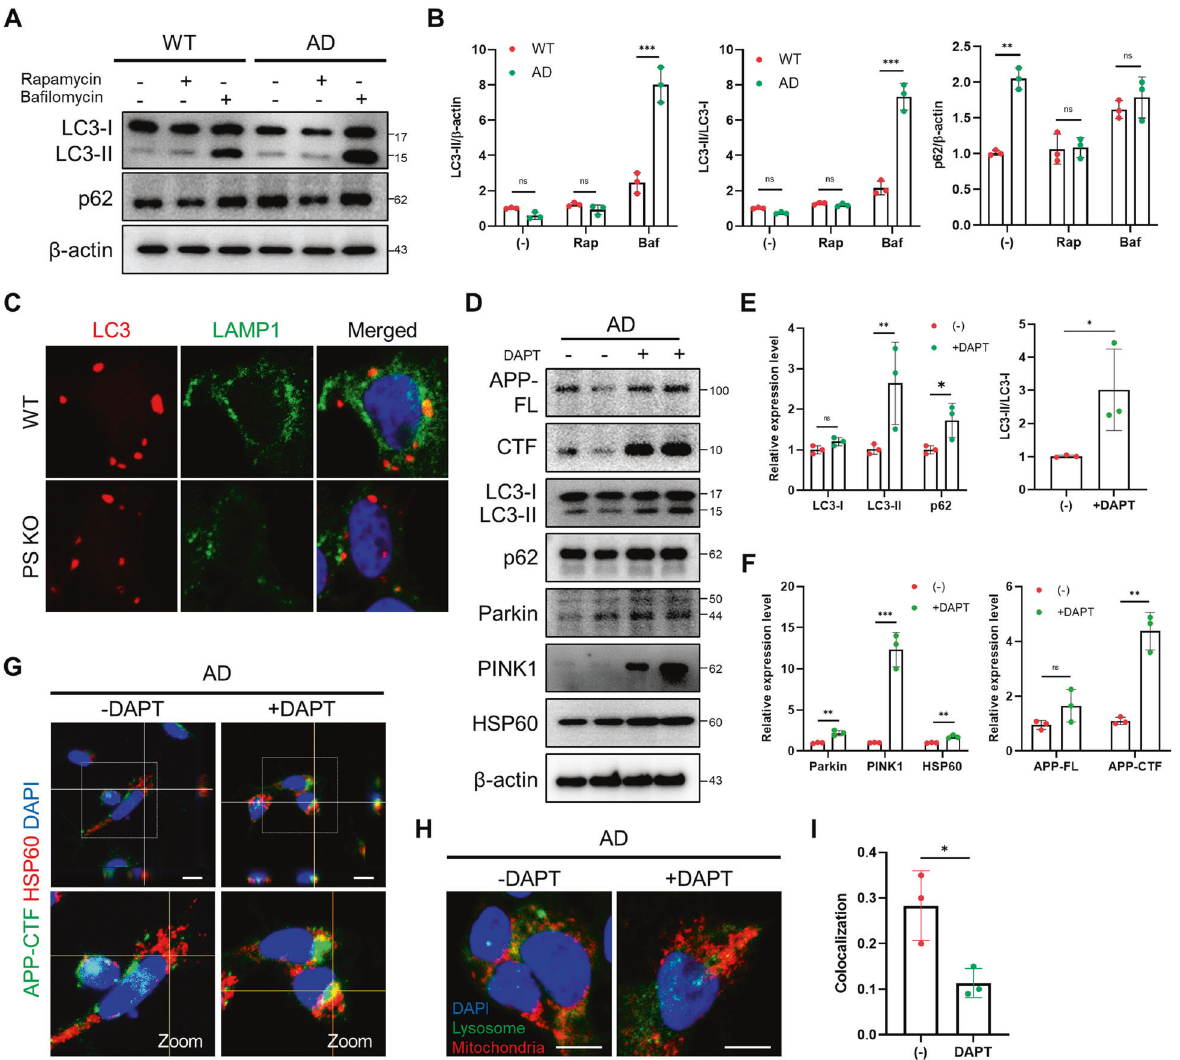
in WT- and AD-iNSCs with respect to control iNSCs under vehicle-treated conditions. C Representative images showing LC3 and LAMP1 in WT- and AD-iNSCs under basal conditions. D Representative western blotting showing APP, APP-CTFs, LC3, p62, Parkin, PINK1, HSP60, and β -actin expression in AD-iNSCs treated or not with DAPT for 24 h. E Quanti fi cation of autophagy-related markers, including LC3 and p62, in the presence of DAPT relative to vehicle treatment. F Quanti fi cation of APP-CTFs and mitophagy-related markers, including Parkin, PINK1, and HSP60, in the presence of 10 µM DAPT relative to vehicle treatment. G Representative z-stack images showing APP-CTF in green and HSP60 as a mitochondrial membrane marker in red in AD-iNSCs treated with 10 µM DAPT for 24 h. Scale bars, 20 µm. H Representative images showing LAMP1 (Lysosome marker) and MitoTracker (Mitochondria marker) in AD-iNSCs treated or not with DAPT for 24 h. Scale bars, 10 µm. I Quanti fi cation of colocalization area with LAMP1 and MitoTracker. Statistical analysis was performed by Student ’ s t -test. n.s not signi fi